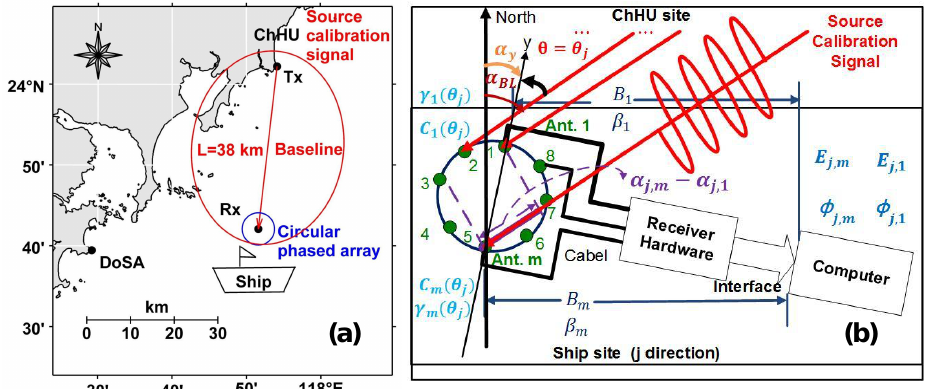
Figure 6. Bistatic geometry of the ChHU and ship sites: ( a ) sketch of the bistatic geometry (Tx: ChHU radar site, Rx: ship radar site); ( b ) detailed drawing of the source calibration signal path (from the receiver antennas to the computer). The phase relative to Ant. 1 φ j , m − φ j ,1 at bearing θ = θ j is extracted from the range spectra, which result from the antenna patterns γ m ( θ j ) − γ 1 ( θ j ) , wave path difference α j , m − α j ,1 , and linking cables and receiver hardware β m − β 1 ; the amplitude relative to Ant. 1 is E j , m / E j ,1 at bearing θ = θ j , which results from the antenna patterns C m ( θ j ) / C 1 ( θ j ) , and linking cables and receiver hardware B m / B 1 .